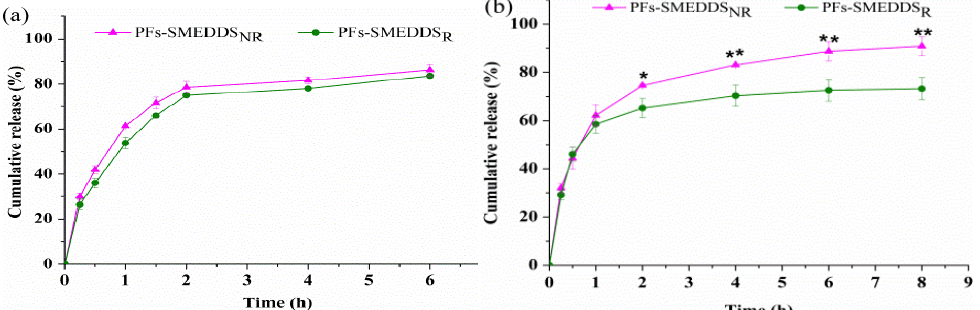
Figure 5. Release profiles of PFs from PFs-SMEDDS NR and PFs-SMEDDS R formulations determined in two different media: ( a ) pH-1.2 hydrochloride solution; ( b ) pH-6.8 phosphate buffer containing 20 mM NaTC and 500 U/mL porcine pancreas lipase (mean ± SD, n = 3). Asterisks indicate significant differences between PFs-SMEDDS NR and PFs-SMEDDS R ; * p < 0.05 and ** p < 0.01.